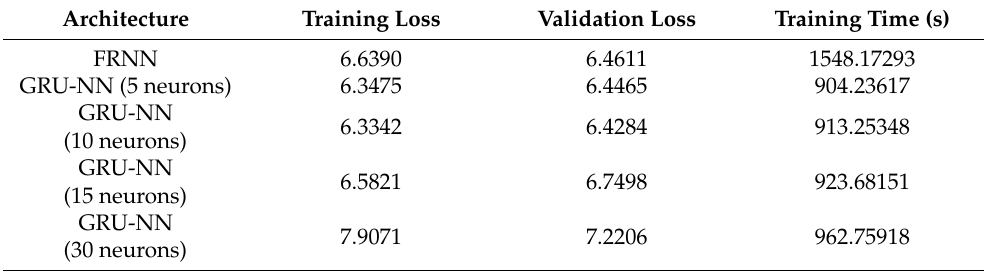
Table 1. Comparison of the deep hedge entropy losses for different architecture types on 50 epochs.